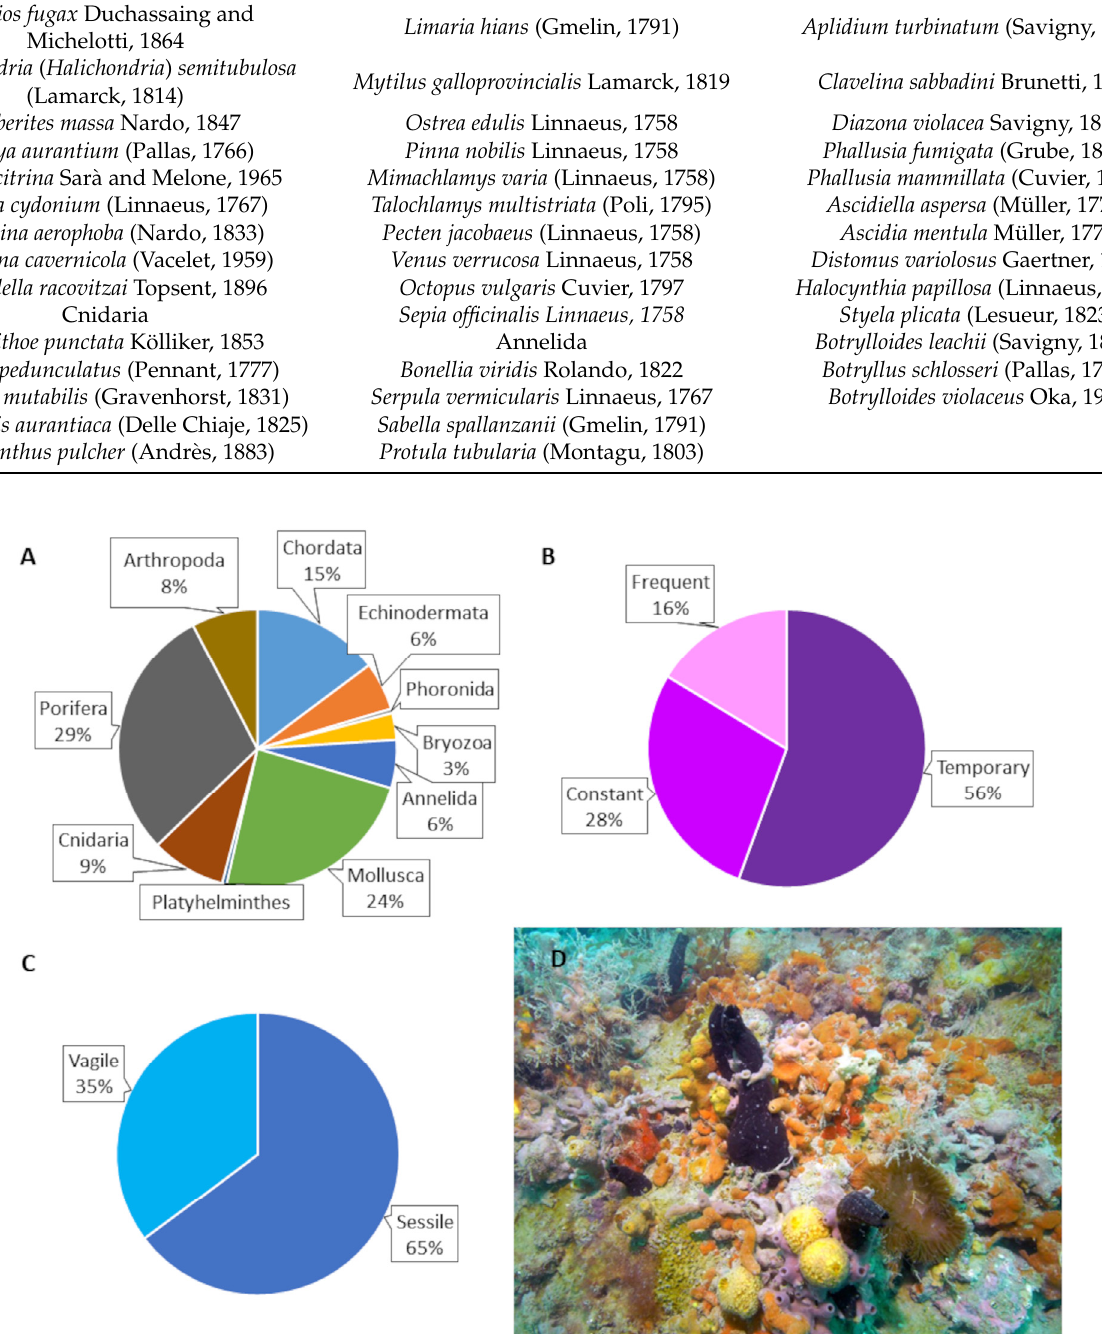
Figure 2. Percentages of phyla ( A ), classes of constancy ( B ), motility modes ( C ) and a picture ( D ) of epibenthic invertebrates found on rocky outcrops. Photo by L. Faresi. With regard to the constancy index, 55 taxa were assessed as constant, 32 as frequent and 109 as temporary; no taxon was recorded as permanent (Figure 2B). Among the con- stant taxa, phylum Porifera was dominant (24 taxa), followed by Mollusca (7), Chordata (7), Annelida (6), Echinodermata (5), Bryozoa (3), Cnidaria (2) and Arthropoda (1); four constant species are protected (Porifera: Sarcotragus foetidus , Tethya aurantium , Geodia cy- donium and Aplysina aerophoba ), one species was characteristic of coralligenous biocenosis (Porifera: Haliclona mediterranea ) and eleven were considered as common in this habitat (Porifera: Chondrosia reniformis , Cliona viridis , Dysidea avara , Ircinia variabilis , Phorbas ficti- tious , G. cydonium ; Mollusca Gastropoda: Muricopsis cristata , Calliostoma zizyphinum ; An- nelida: B. viridis ; Chordata: Aplidium conicum , Pyura sp.) (Table S1). Regarding the frequent taxa, Porifera were dominant (10 taxa), followed by Chordata (7), Mollusca (5), Arthropoda (4), Cnidaria (3), Annelida (2) and Bryozoa (1); four were protected species (Porifera: Aplysina cavernicola ; Cnidaria: Cladocora caespitosa ; Mollusca Bivalvia: Pinna nobilis ; Arthropoda: Homarus gammarus ), one species was characteristic of coralligenous biocoenosis (Chordata: Cystodytes dellechiajei ) and six were considered as common for this biocoenosis (Porifera: Pleraplysilla spinifera , Oscarella lobularis ; Cnidaria: Scyphozoa Nausithoe punctata and Anthozoa Epizoanthus arenaceus ; Arthropoda: Dromia personata ; Chordata: Polysyncraton lacazei ) (Table S1). Finally, for the temporary taxa, Mollusca dominated (35 taxa), followed by Porifera (24), Chordata (15), Cnidaria (12), Arthropoda (10), Echinodermata (6), Annelida (3), Bry- ozoa (2), Platyhelminthes (1) and Phoronida (1); six are protected species (Porifera: Axi- nella polypoides , Axinella cannabina , Spongia officinalis , Tethya citrina ; Arthropoda: Scyllarus arctus ; Echinodermata: Paracentrotus lividus ), two species were characteristic of coralligen- ous (Porifera: Agelas oroides and Axinella damicornis ) and four were common species (Po- rifera: Scalarispongia scalaris ; Cnidaria: Cornularia cornucopiae , Maasella edwardsii ; Mollusca